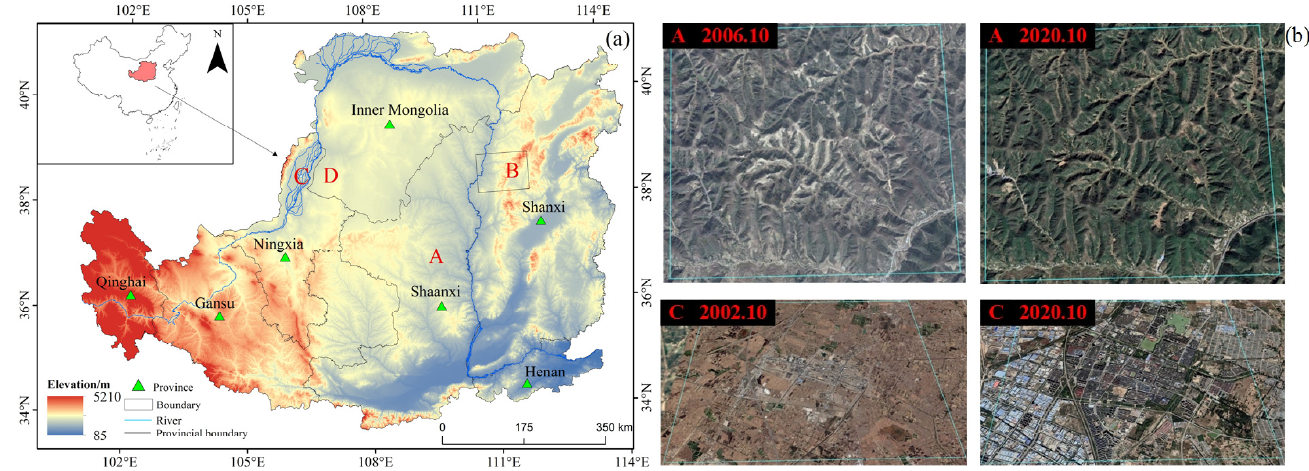
Figure 1. Location of the study area. A and B show an increase in vegetation after the Grain for Green Project, while C and D show the expansion of cities in ( a ) and A and C are from Google Earth satellite images in ( b ), and B and D are for subsequent analysis.